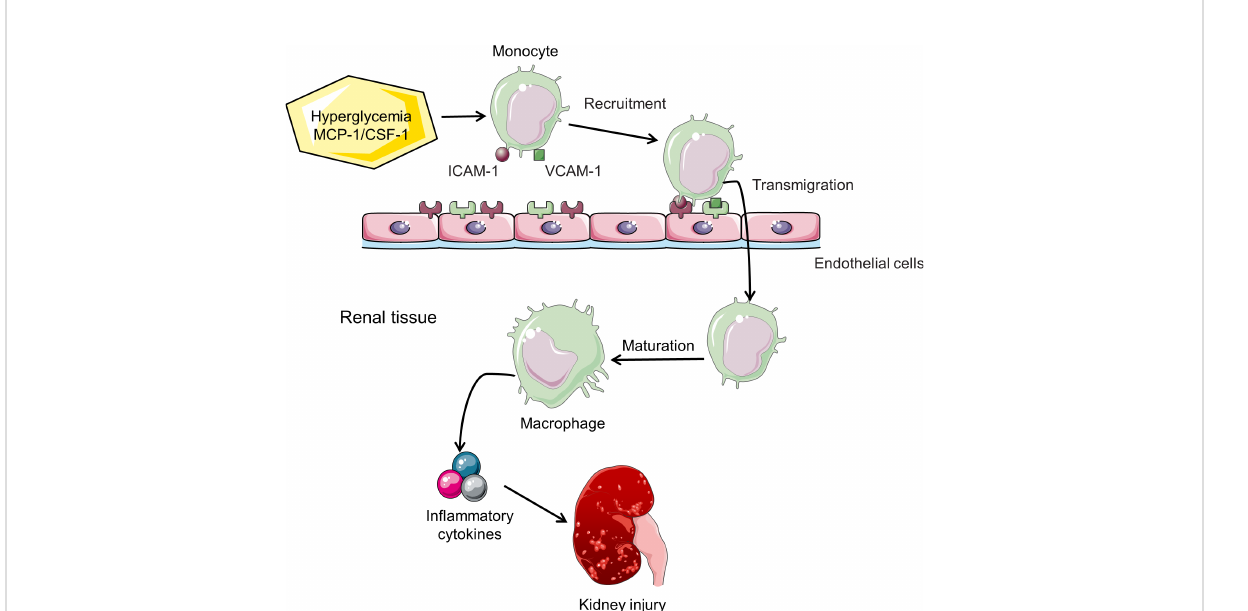
FIGURE 2 Macrophage recruitment and activation in DN. Hyperglycemia induces increased expression of cell adhesion molecules (ICAM-1/VCAM-1) and chemokines (MCP-1/CSF-1), thereby enhancing the recruitment of monocytes to the kidney. Chemokines also promote transendothelial migration. Monocytes mature into macrophages and subsequently release in fl ammatory cytokines, leading to the progression of